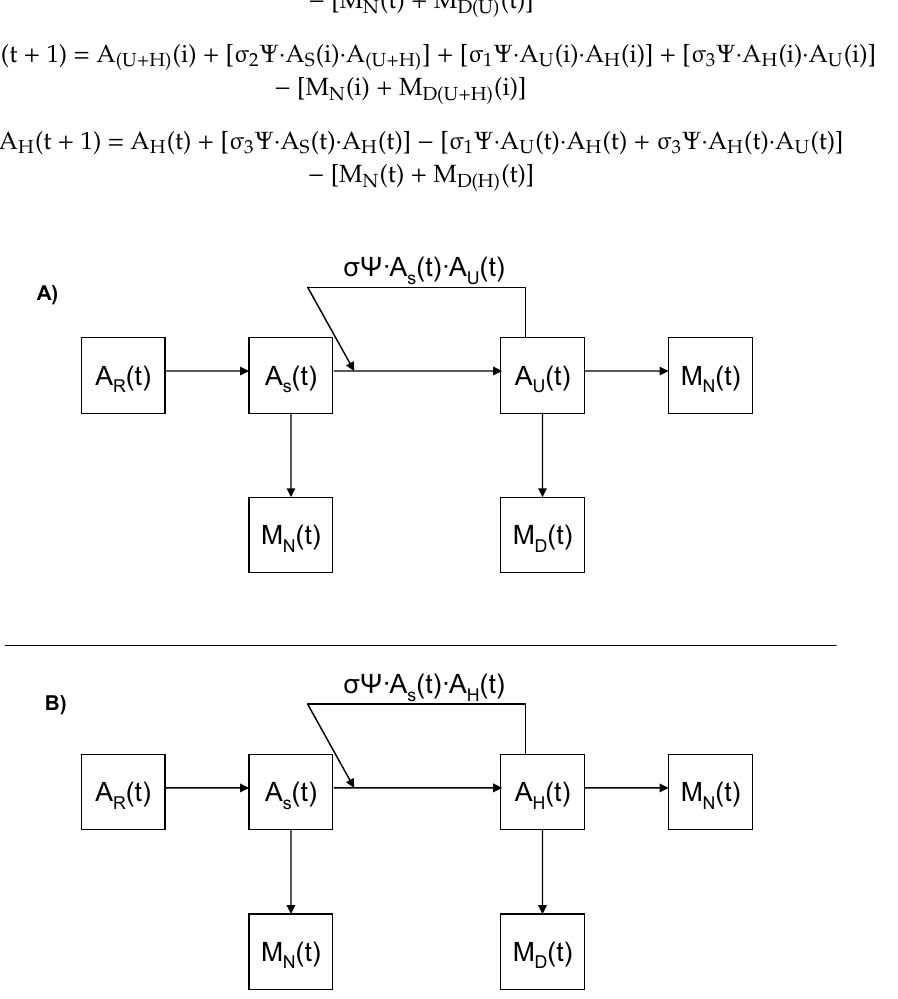
Figure 7. Diagrammatic representations of the transmission dynamics of the ranavirus when only the A S or A H causing isolate of the ranavirus is present. ( A ) When only the ulcerative form of the ranavirus is present within the population. ( B ) When only the hemorrhagic form of the disease is present in the population. All of the variables present are the same as described above and all have a time component associated with them. Where A s is the number of susceptible individuals, Ψ is the contact rate, σ is the likelihood of transmission, M N is the natural mortality rate, and M D is the mortality rate associated with ranavirosis.